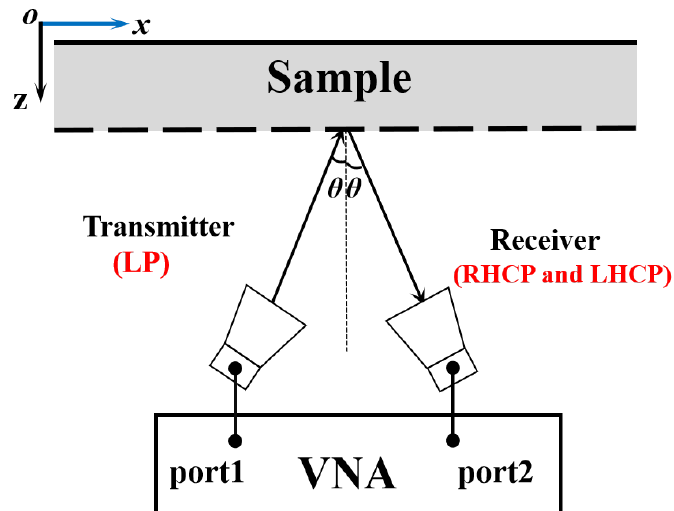
Figure 11. Structural diagram of the measurement setup.